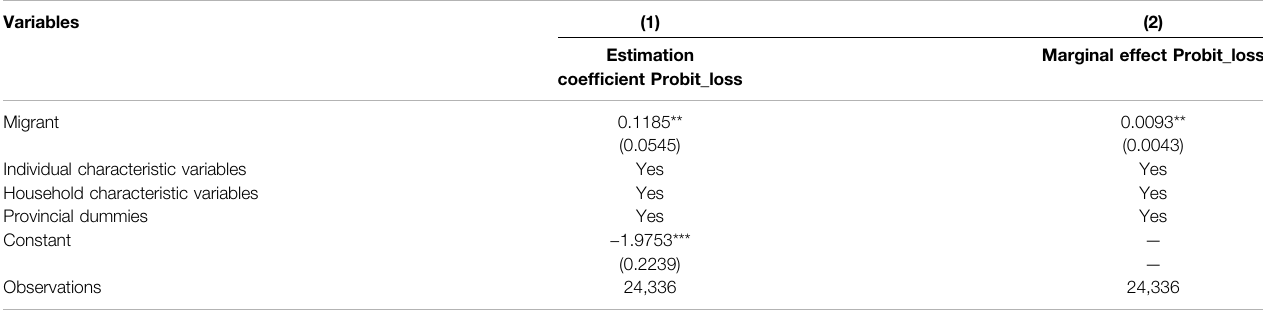
TABLE 5 | The Probit model estimation of the risk of households being defrauded on migrant.